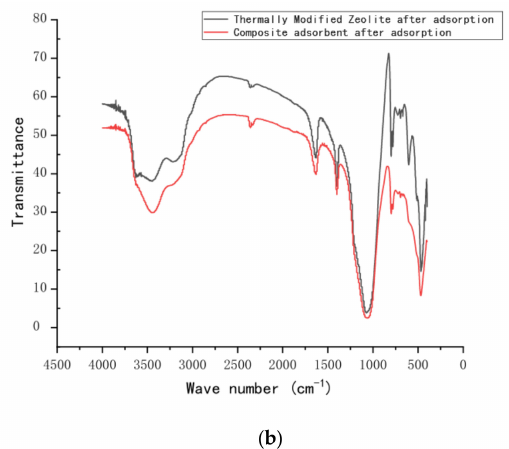
Figure 10. FT-IR spectra of ( a ) natural green and thermally modified zeolite and ( b ) thermally modified zeolite and composite adsorbent after adsorption.